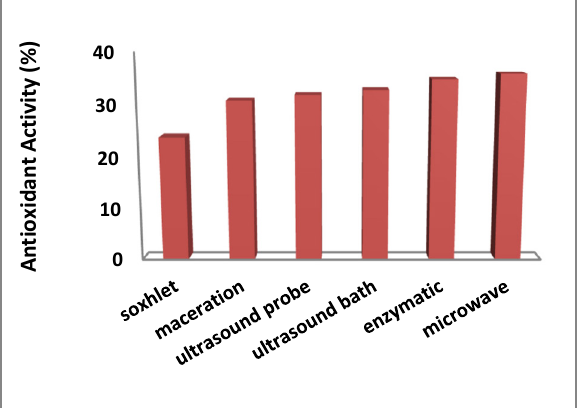
Fig. 2. Evaluation of different extraction methods on